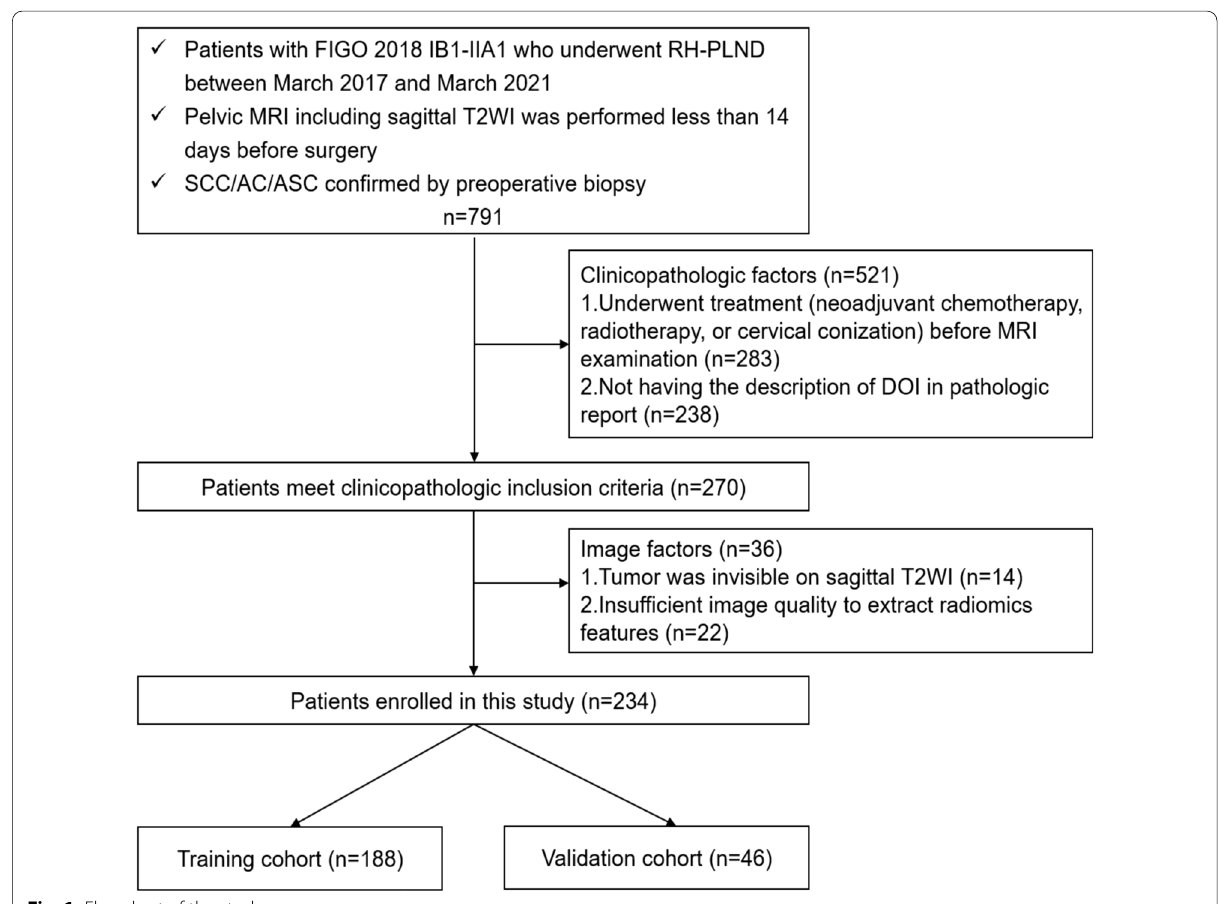
ratio of 8:2. The clinical characteristics of all enrolled patients, including age, 2018 FIGO stage, menopausal status, preoperative biopsy histological type, and max- imal tumor diameter (MTD) on MR images that the lesions appeared largest, were obtained from medical records. Clinical and imaging records of the patients before 2018 were reviewed by a gynecological oncolo- gist with 10 years of experience and were restaged according to the 2018 FIGO staging criteria [29]. Postoperative pathological examination results were the gold standard in this study. DOI was measured as a percentage of the tumor depth to the cervical radius in millimeters (mm) and was recorded in the pathol- ogy report as “tumor depth/cervical radius (mm)” [6]. Superficial 1/3 stromal invasion was defined as “super- ficial stromal invasion” and middle or deep 1/3 stromal invasion as “middle or deep stromal invasion”